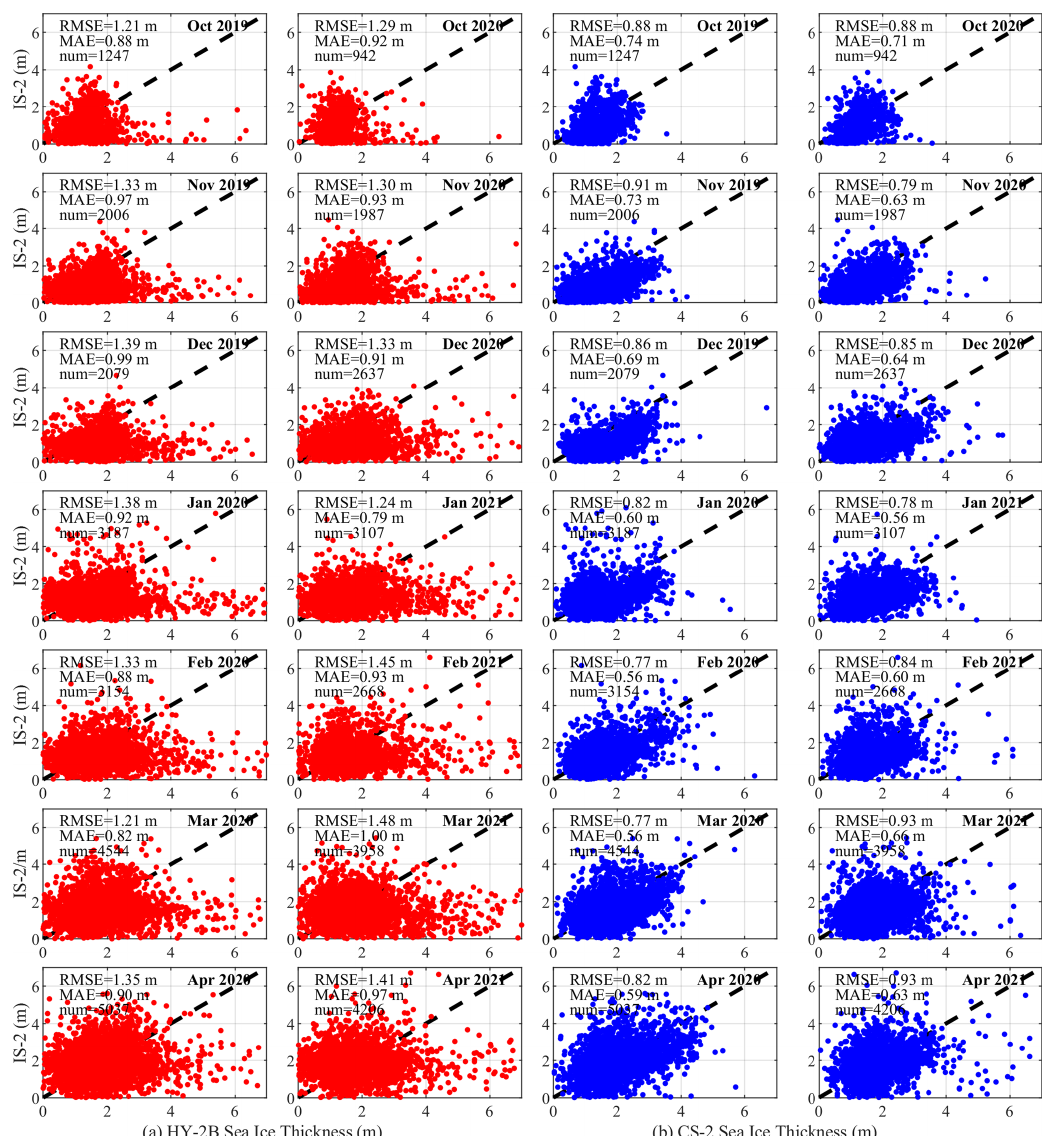
Figure 10. Monthly comparisons between HY-2B sea ice thickness and ICESat-2 sea ice thickness and between CryoSat-2 sea ice thickness and ICESat-2 sea ice thickness: panel (a) shows comparisons between HY-2B and ICESat-2 in red points, and panel (b) shows comparisons between CS-2 and ICESat-2 in blue